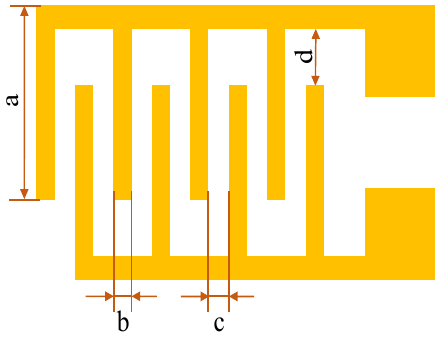
Figure 1. The interdigitated electrode.